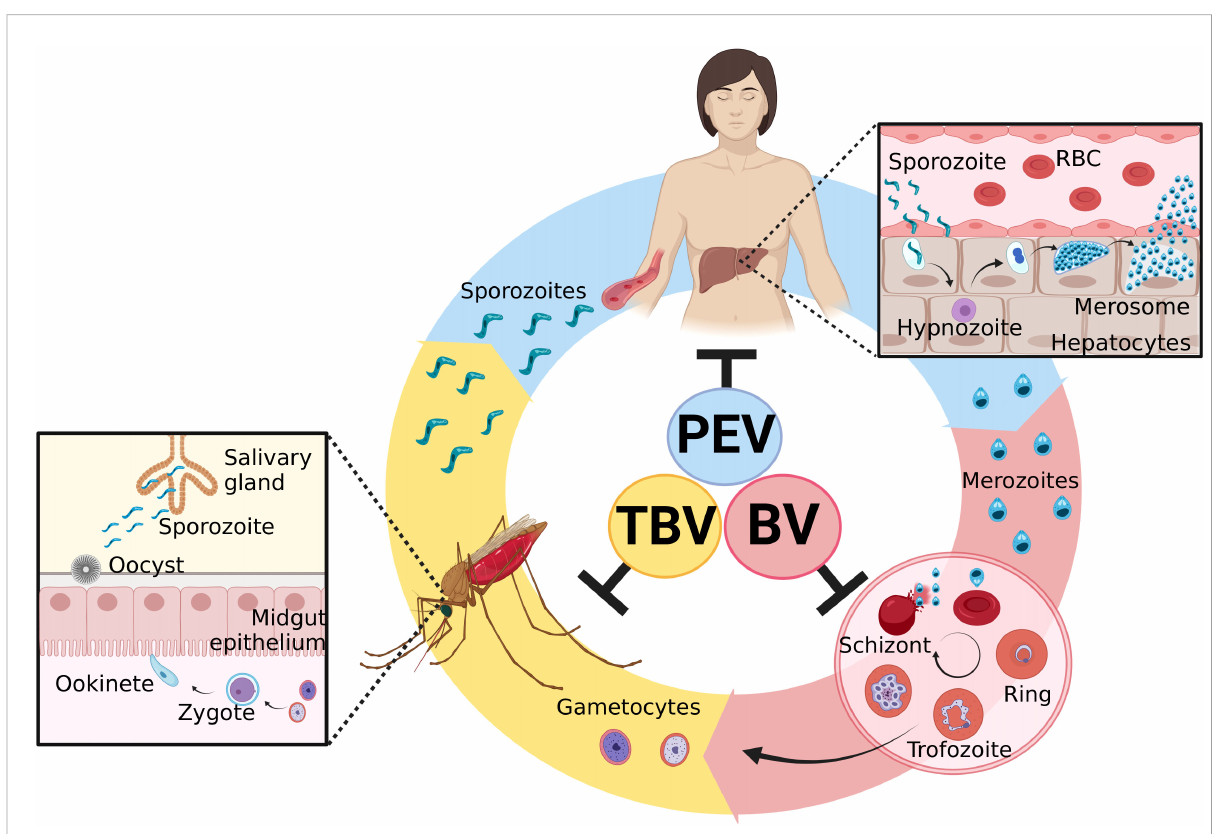
FIGURE 1 Plasmodium vivax life cycle and targets of malaria vaccines. Sporozoites are inoculated in the host skin during the blood repast of female Anopheles spp. They move to the liver by the circulatory system and invade hepatocytes. PEVs (preerythrocytic vaccines) are designed to block this step. Inside the liver cells, morphological changes occur in the parasite and might lead to the development of hypnozoites, the latent hepatic form. After its activation, the liver schizont is formed, followed by the merosome. When it ruptures, it releases merozoites into the blood circulation. BV (blood vaccines) are designed to prevent the invasion of reticulocytes by merozoites. After erythrocyte invasion, new forms are generated, including male and female gametocytes, which stay in the blood. If a new blood repast happens, these forms are ingested by mosquitoes, where the sexual cycle takes place. The gametocytes fertilize, giving rise to the zygote and then the ookinete. The ookinete invades the midgut epithelium of the mosquito and originates the oocyst. When it ruptures, it releases sporozoites, which migrate to the salivary gland and can restart the cycle. TBV (transmission-blocking vaccines) are designed to interrupt this development to reduce transmission. Created with